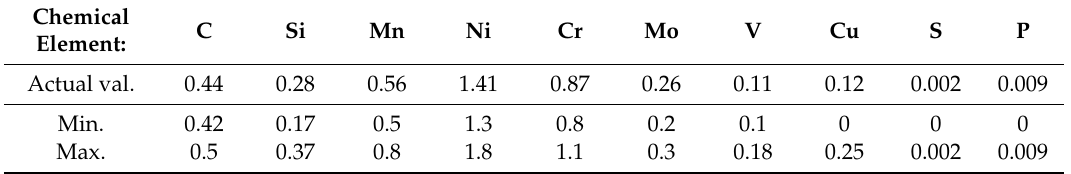
Table 2. Chemical composition in wt. % of the used material, equal to that in [3].